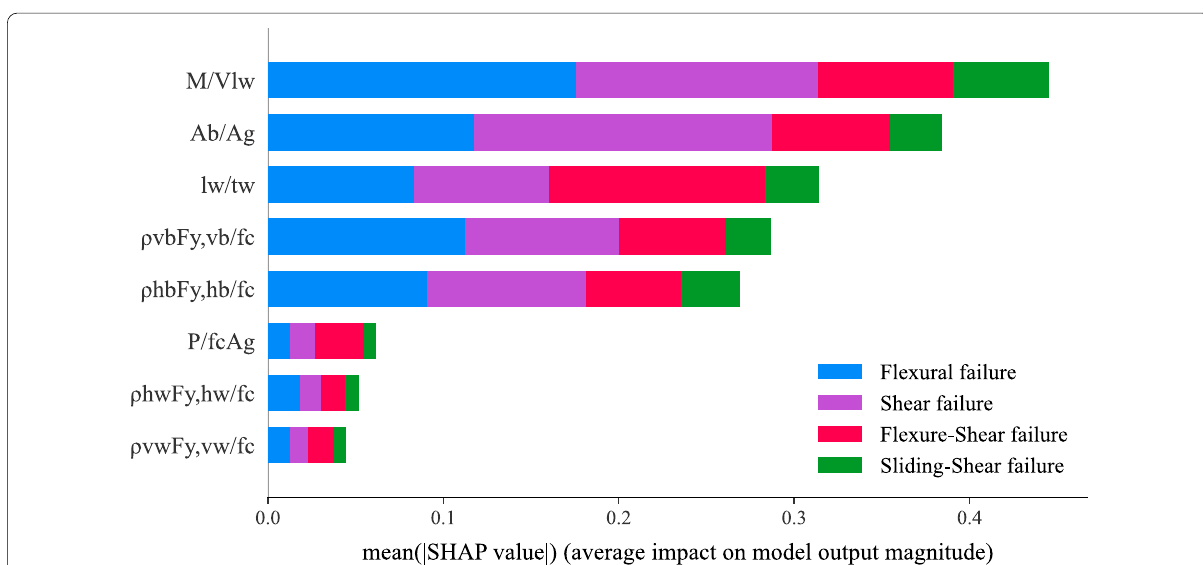
Fig. 11 Failure mode—SHAP summary